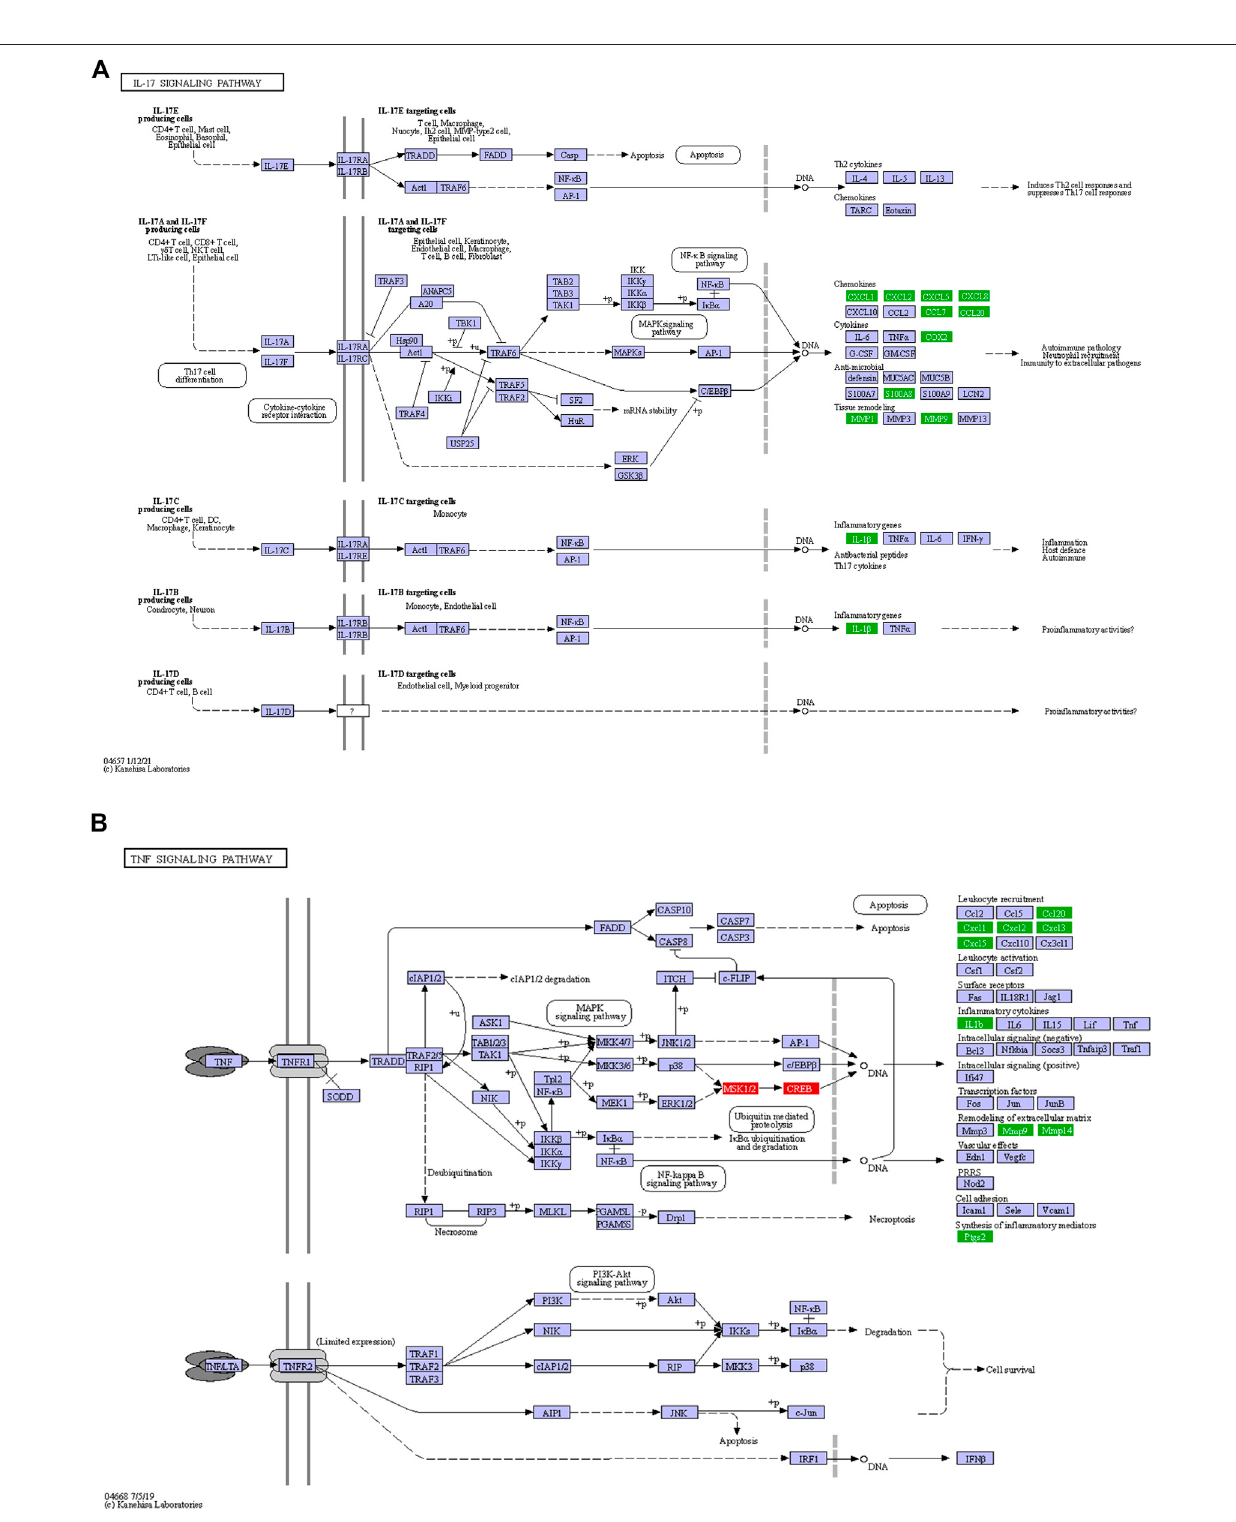
FIGURE 4 | In fl ammatory response in LGMDD2 patients evidenced by altered IL-17 (A) and TNF (B) signaling pathways. Green coloured genes represent overexpressed genes in LGMDD2 patients whereas red coloured genes represent genes downregulated in these individuals.